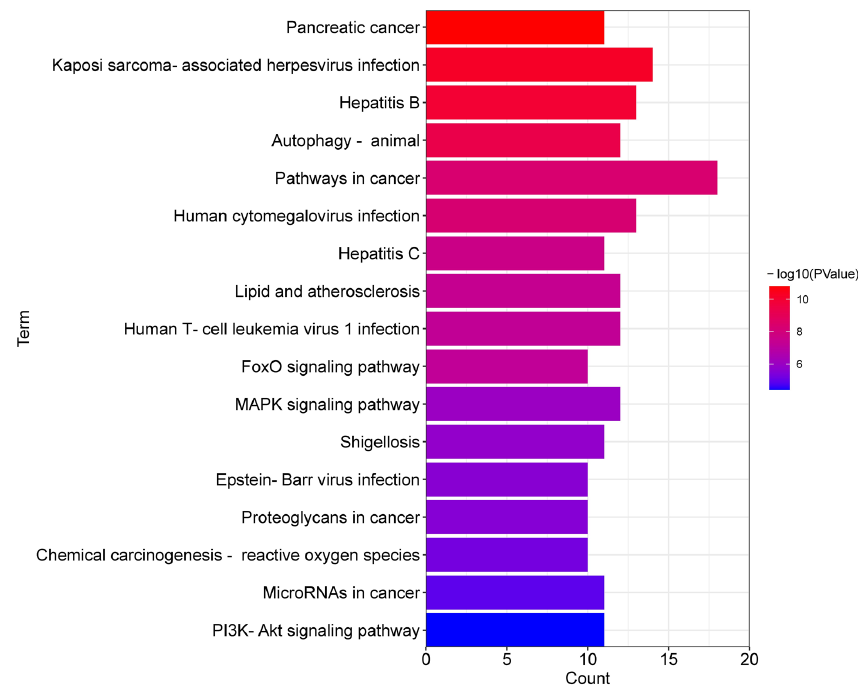
Figure 4. Significant KEGG pathways of ferroptosis-related DEGs.